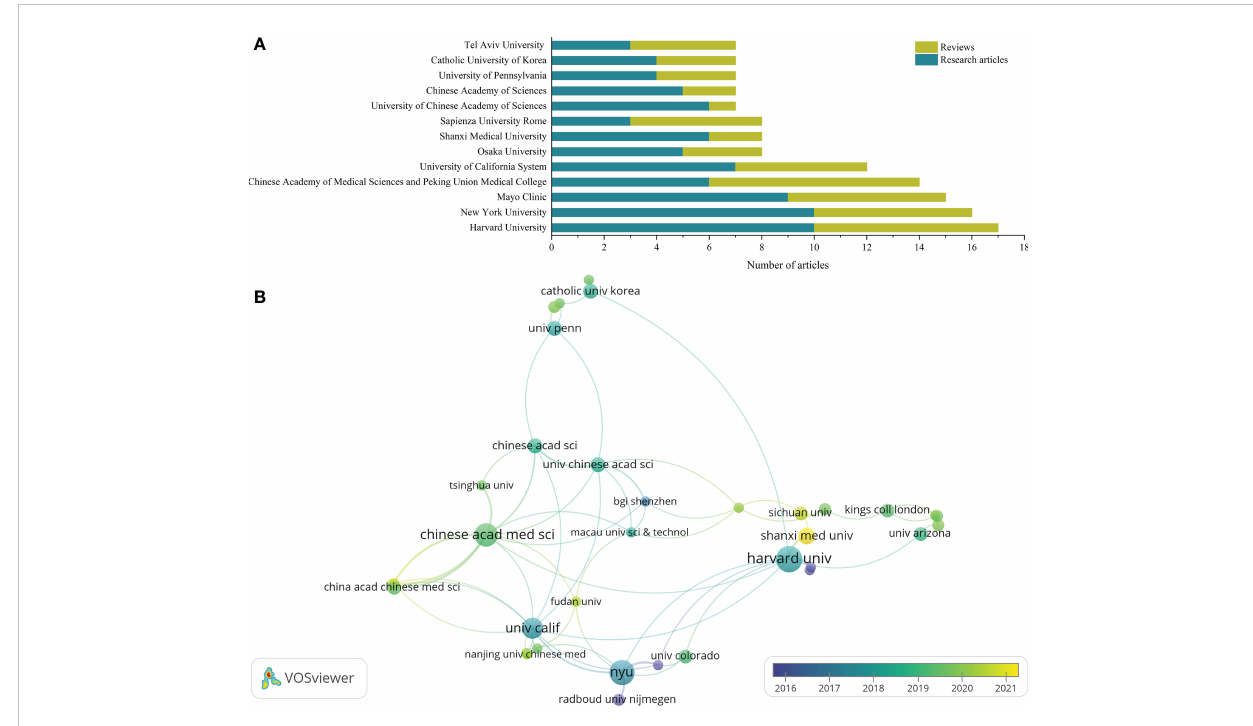
FIGURE 3 Visualization of af fi liations analysis. (A) The top 10 af fi liations with the most publications; (B) Cooperation networks across af fi